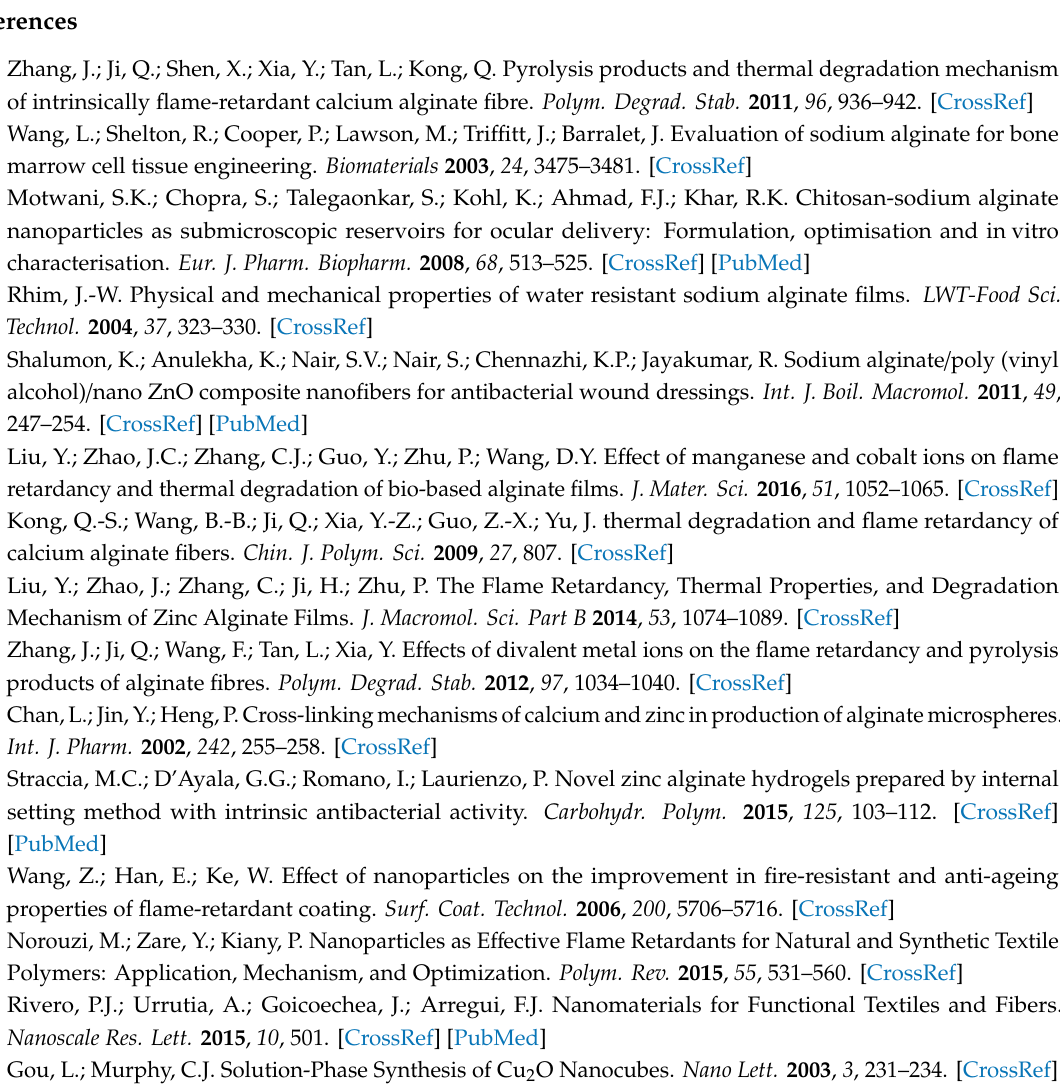
Figure S1: The XPS spectra of survey for ZnAlg / Cu 2 O; Figure S2: Py-GC-MS spectra of ZnAlg at 750 ◦ C; Table S1: Pyrolysis products of ZnAlg at 750 ◦